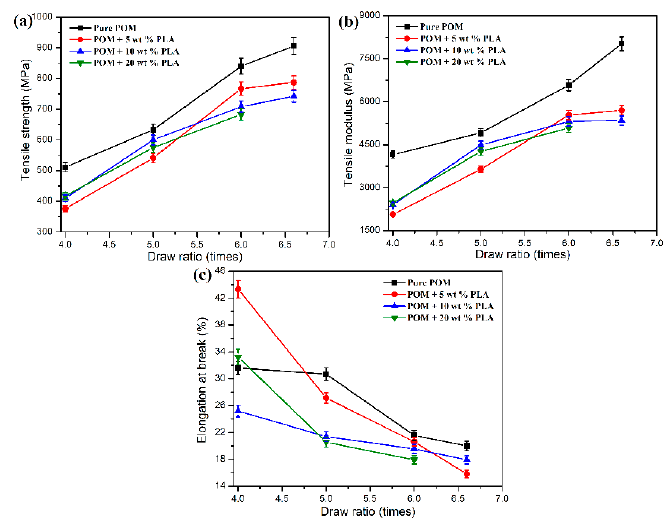
Figure 11. ( a ) Tensile strength, ( b ) tensile moduli, and ( c ) elongation at break of pure POM fiber and POM/PLLA bicomponent fibers at different draw